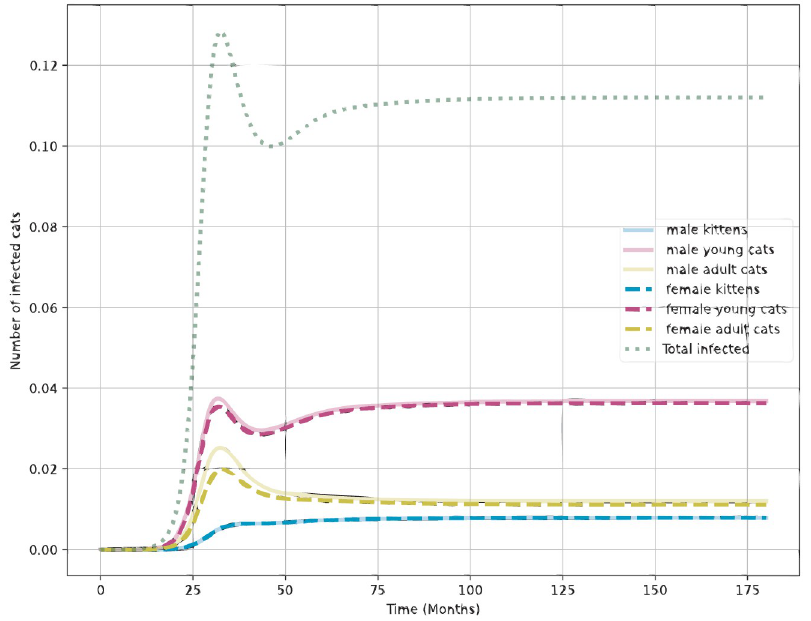
Fig 4. Effect of a treatment rate of 0.5 on the endemic prevalences. Y-axis represents fraction of the entire population.